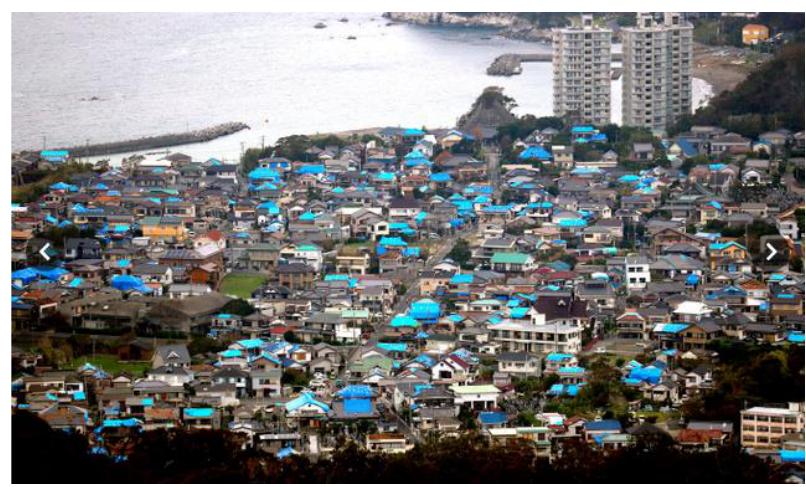
Figure 12. Aerial photograph of Kyonan town captured on 14 September 2019 [40].